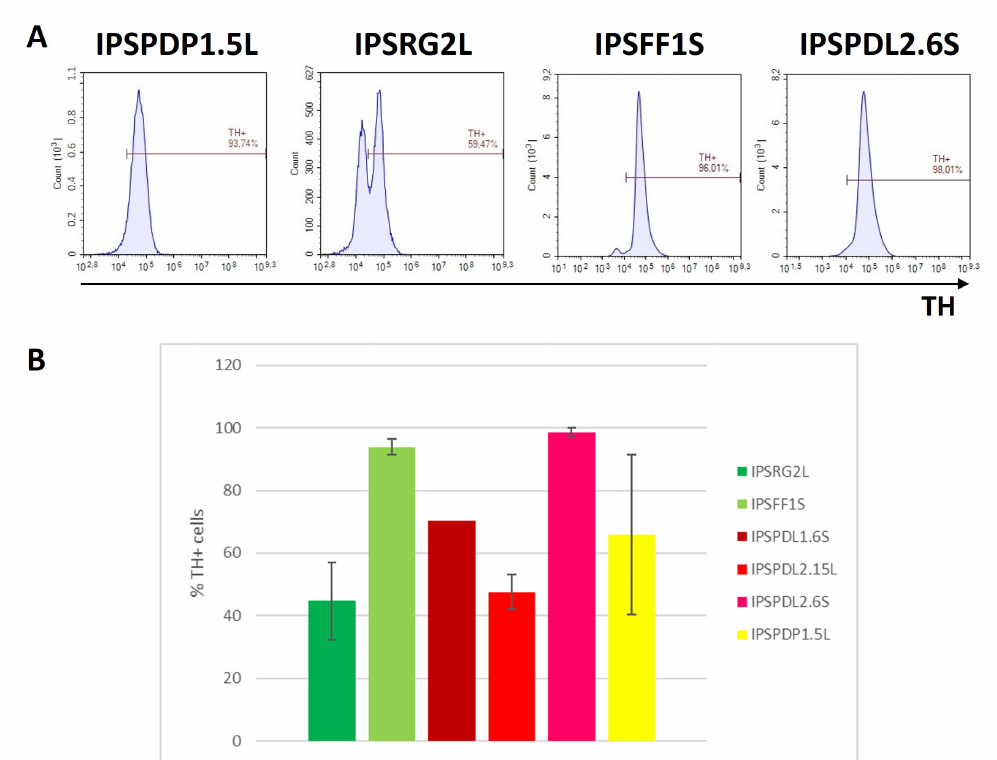
Figure 5. Flow cytometry analysis of neurons differentiated from iPSCs obtained from the mate- rial of patients with PD and from a healthy donor, on differentiation day 65. ( A )—anti-TH staining. IPSPDP1.5L—iPSC line from PD patient with mutation in PARK2 gene; IPSRG2L and IPSFF1S—iPSC lines from healthy donor; IPSPDL2.6S—iPSC line from PD patient with mutation in PARK8 gene. ( B )—results of analysis of neuronal populations for TH expression presented in graphical view (n = 1–4). The bars represent the mean ±